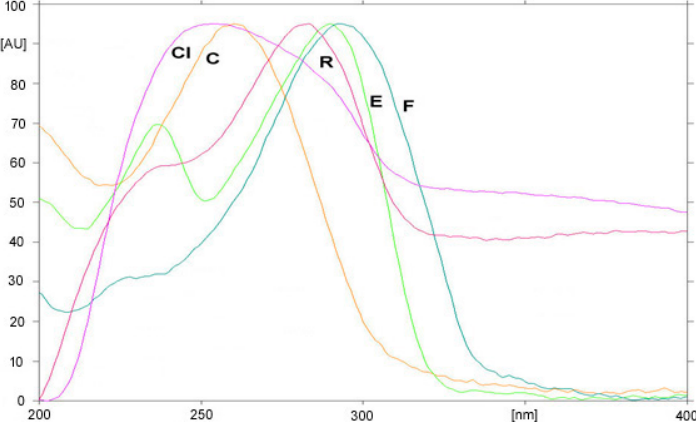
Figure 3. An absorption spectra registered for analyzed compounds obtained directly from the chromatogram (C-celecoxib; E-etoricoxib; CI-cimicoxib; F-firocoxib; R-robenacoxib).